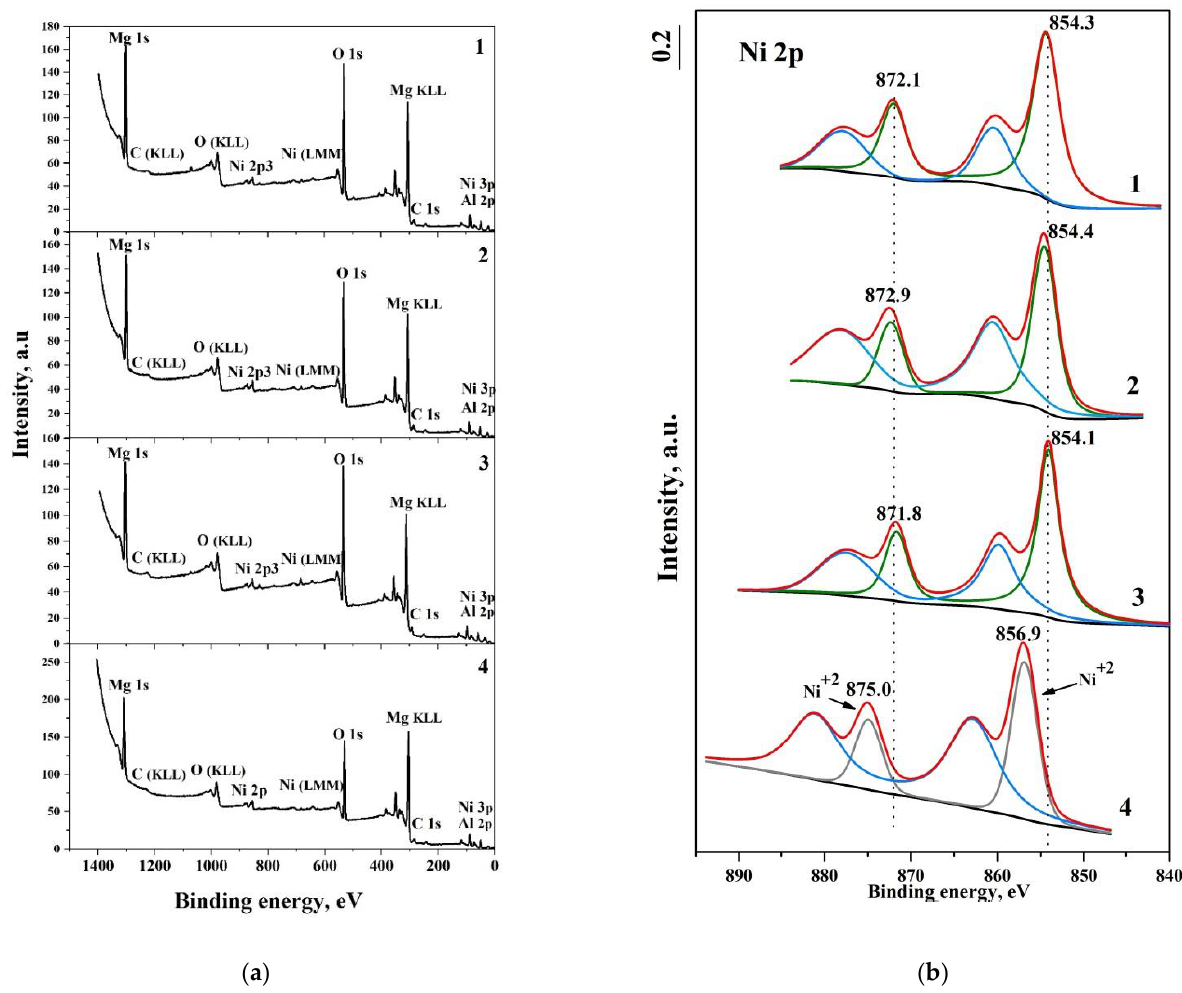
Figure 8. ( a ) XPS survey spectra and ( b ) spectra of the levels of Ni 2p atoms of the Mg/AlNi-25 sample, synthesized under different conditions: 1 — Mg/AlNi-25-c, 2 — Mg/AlNi-25-ht, 3 — Mg/AlNi-25-mw, 4 — Mg/AlNi25-ox .